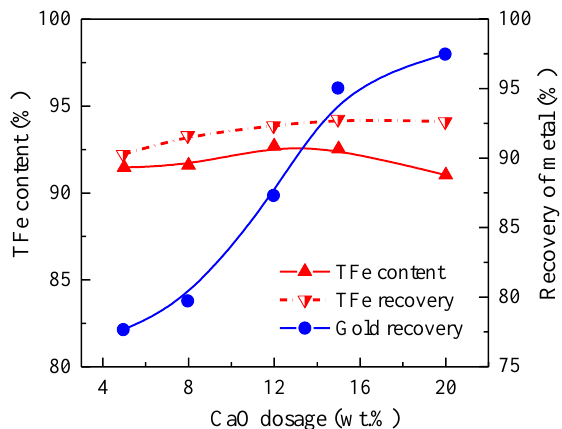
Figure 5. Effect of CaO dosage on the recovery of iron and gold from cyanide tailings. (Reduction conditions: reduction temperature of 1200 ◦ C, reduction time of 90 min, coal dosage of 20